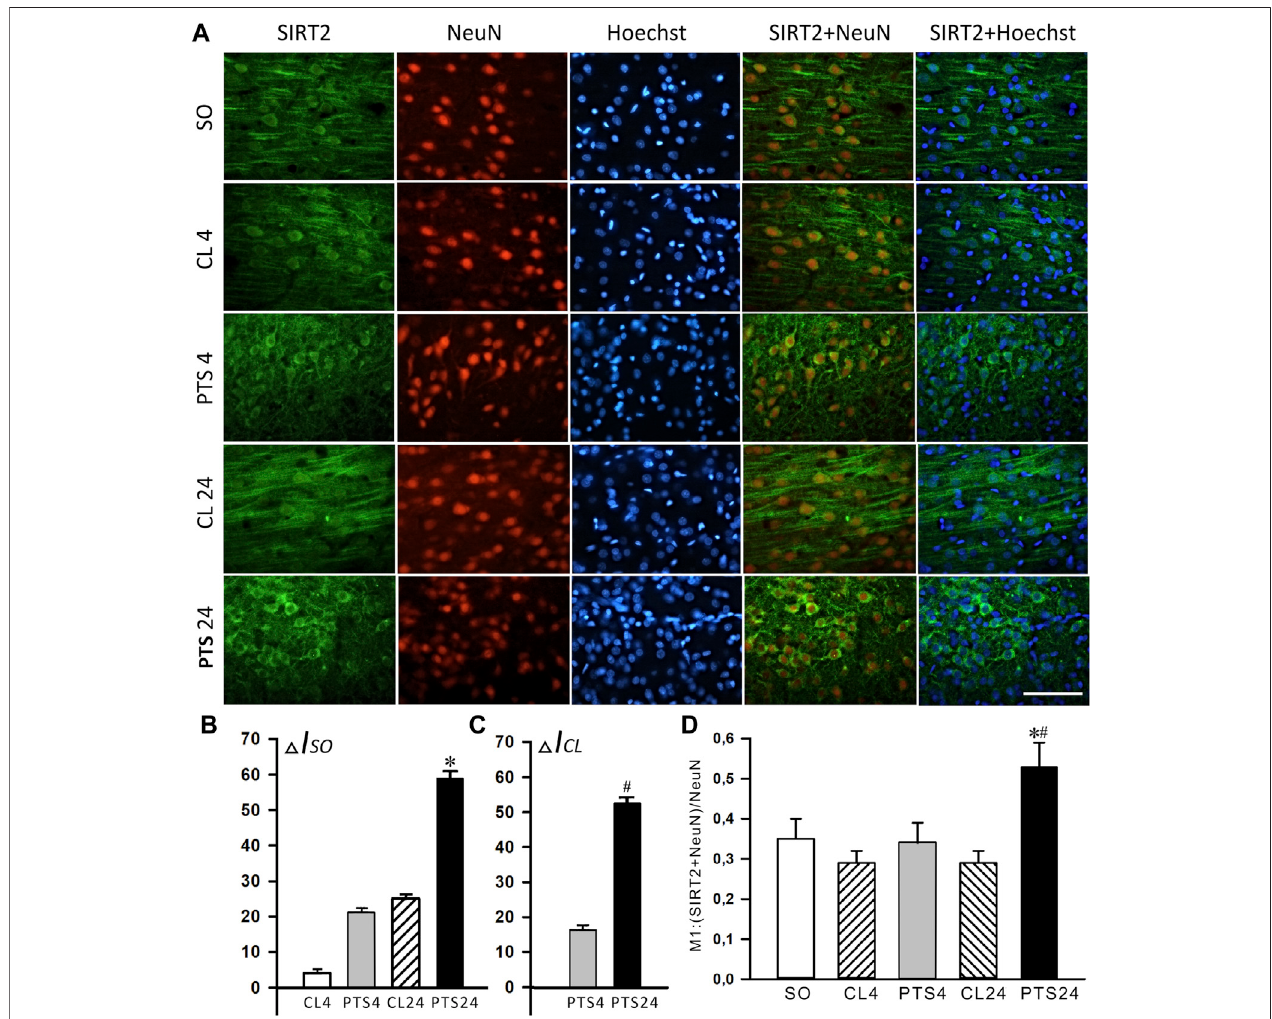
FIGURE5| SIRT2levelsandlocalizationintheneuronsofischemicpenumbra4and24 hafterphotothromboticstrokeintheratcerebralcortex(PTS4andPTS24, respectively) compared to the same animals ’ contralateral cortex (CL4 and CL24), or the cortex of sham-operated animals (SO). (A) Immuno fl uorescence of SIRT2 (green),neuronalmarkerNeuN(red), nuclearchromatin markerHoechst 33342(blue),and imageoverlay. Thescalebar is100 μ m. (B) Percentchanges( Δ ISO)ofSIRT2 levels in the penumbra (PTS4 or PTS24) and the contralateral hemisphere (CL4 or CL24) compared to the brain cortex of sham-operated rats (SO) 4 or 24 h after PTS. (C) Percent changes ( Δ ICL) of SIRT2 levels in the penumbra (PTS4 or PTS24) compared to the contralateral cortex of the same rats 4 or 24 h after PTS. (D) Coef fi cient M1 of SIRT2 co-localization with the neuron marker (NeuN) in different control and experimental groups. One Way ANOVA; M ± SEM; n =